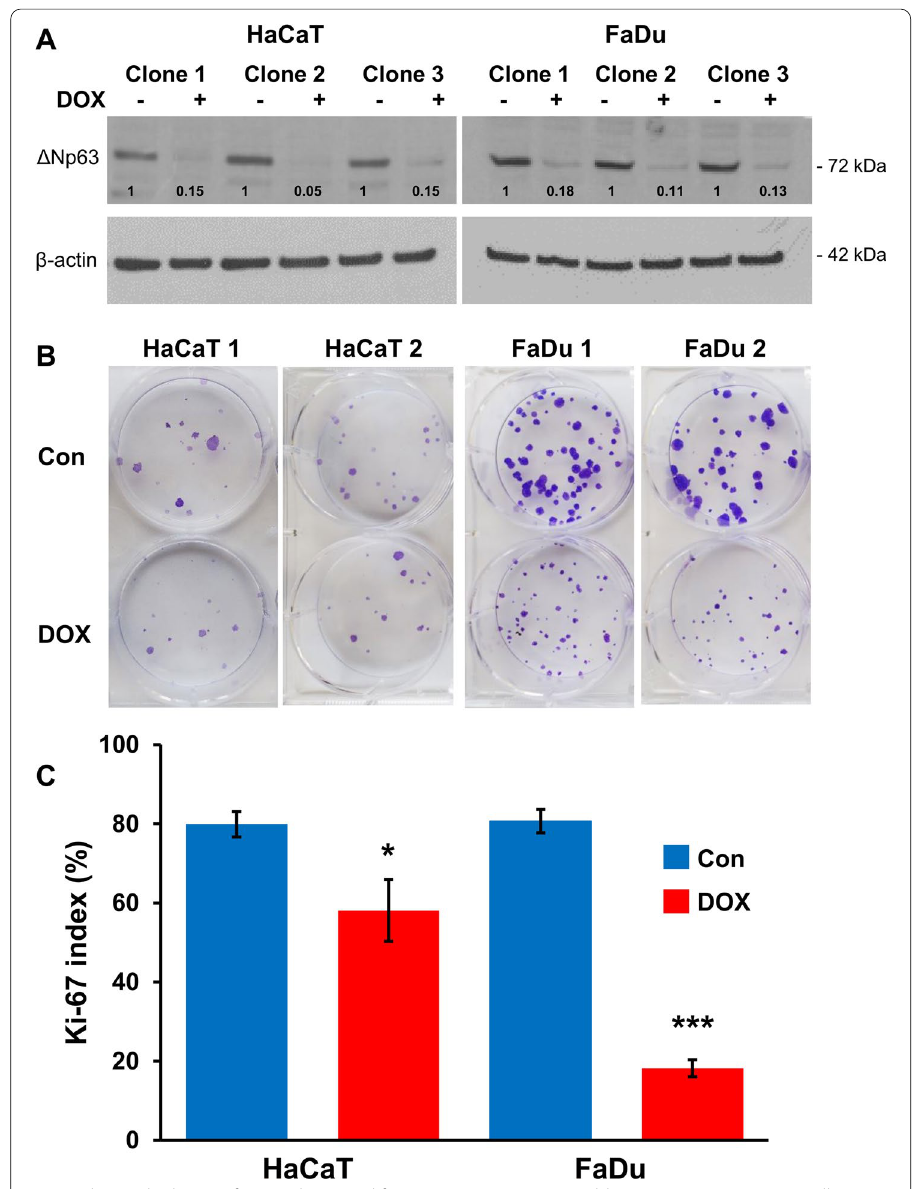
Fig. 1 shRNA depletion of p63 reduces proliferation. A ΔNp63 western blotting in HaCaT or FaDu cells containing doxycycline-inducible p63 shRNAs with or without doxycycline (DOX) for 24 h. β-actin is shown as loading control. Relative densitometry measurements of ΔNp63 are shown after normalizing to β-actin; control cells are designated as 1 for each clone. B Crystal violet staining of colonies formed with or without doxycycline for 4 days from 2 stable clones of HaCaT or FaDu shRNA-p63 cells. C Percentages of Ki67 in HaCaT or FaDu cells growing with doxycycline (DOX) or control cells without doxycycline (Con) for 4 days. *p < 0.05;***p < 0.001 for doxycycline treated cells compared to the same cells growing without